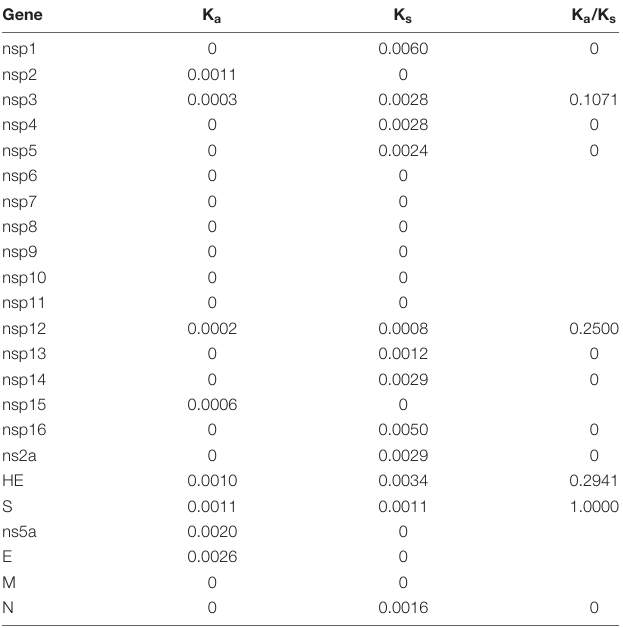
TABLE 3 | Estimation of non-synonymous and synonymous substitution rates of the novel HCoV-OC43 genotype. Gene K a